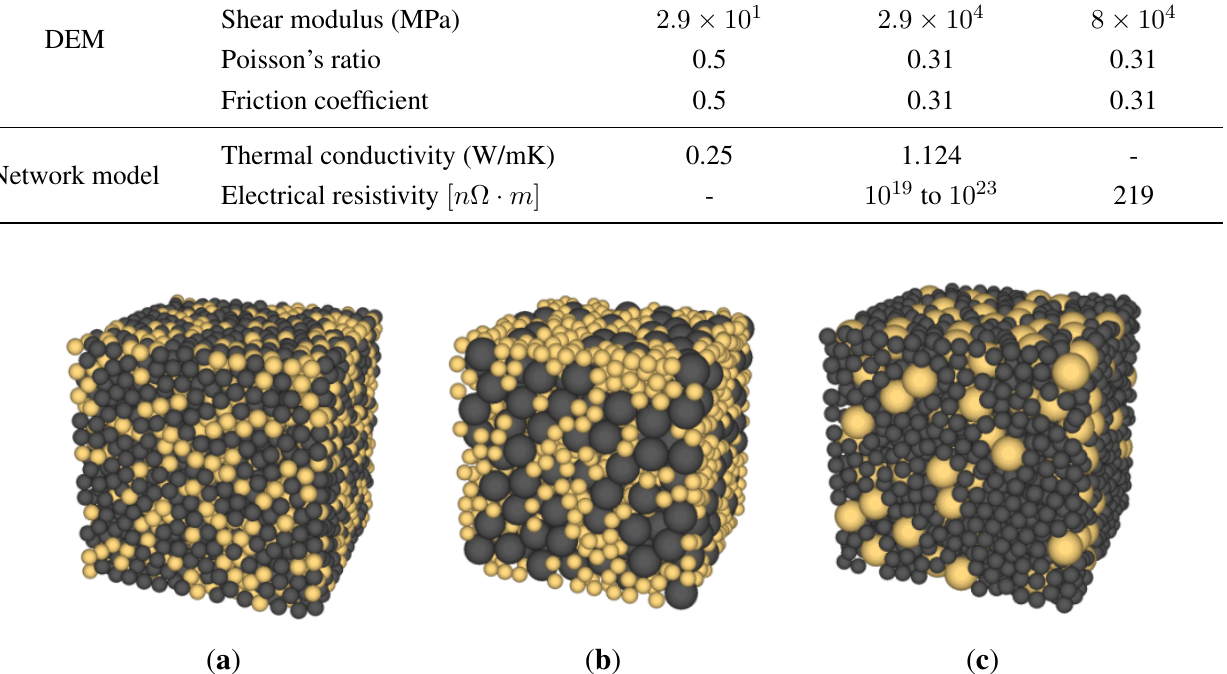
Figure 2. Particle assemblies for glass bead (GB) and rubber (R) mixture ( F where the yellow color denotes glass beads and a dark color indicates rubber particles = D /D ∼ 1 ; ( b ) Case 2: R ( a ) Case 1: R D R GB R = D /D ∼ 0 . 25 D R GB